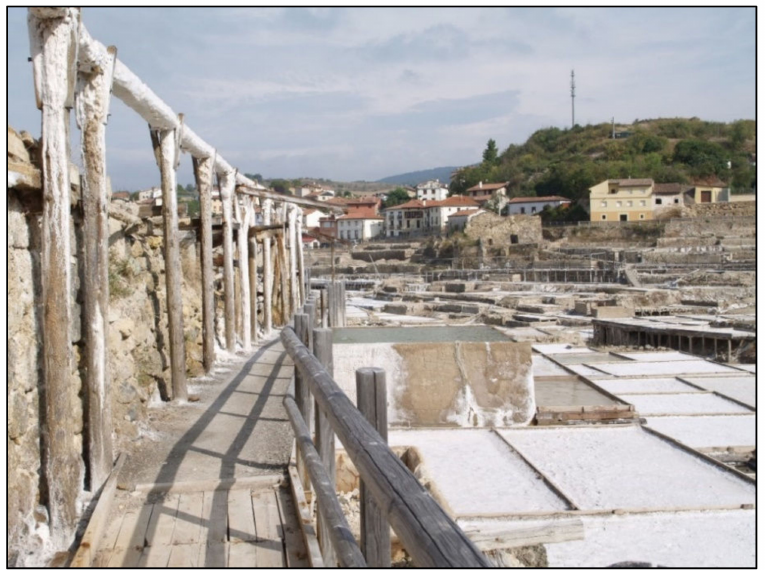
Figure 2. View of some of the restored saltpans and channels in the Salado valley of Añana. This section can be visited on guided tours only. Own